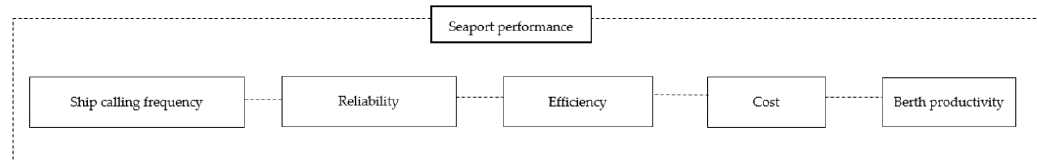
Figure 7. Seaport performance framework.